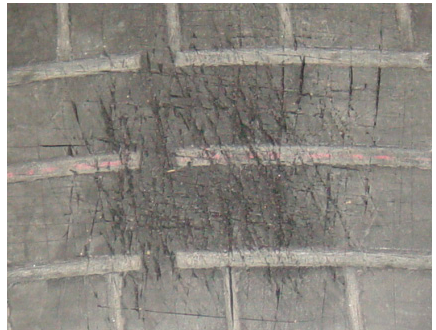
Figure 27. Abrasion.